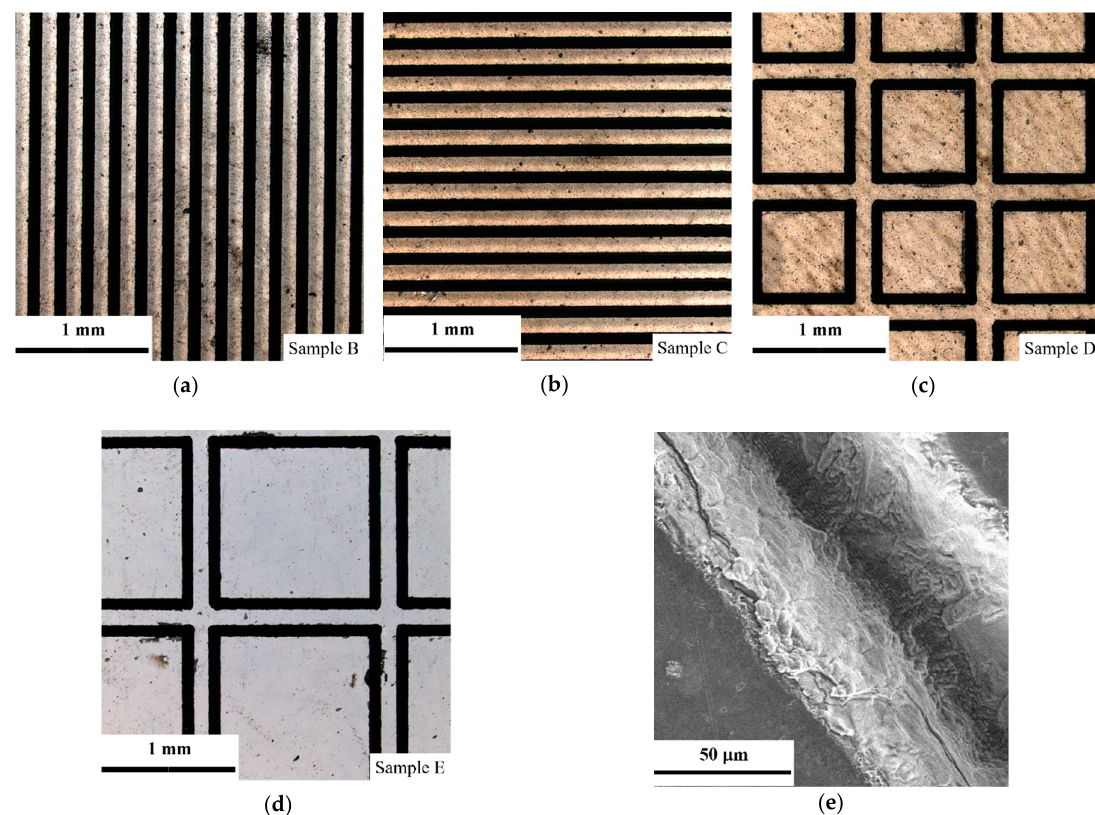
Figure 3. Morphologies of diamond films with graphite fibers (GFs) using an optical microscope: ( a ) Sample B; ( b ) sample C; ( c ) sample D; and ( d ) sample E. ( e ) SEM image of a laser-ablated groove.